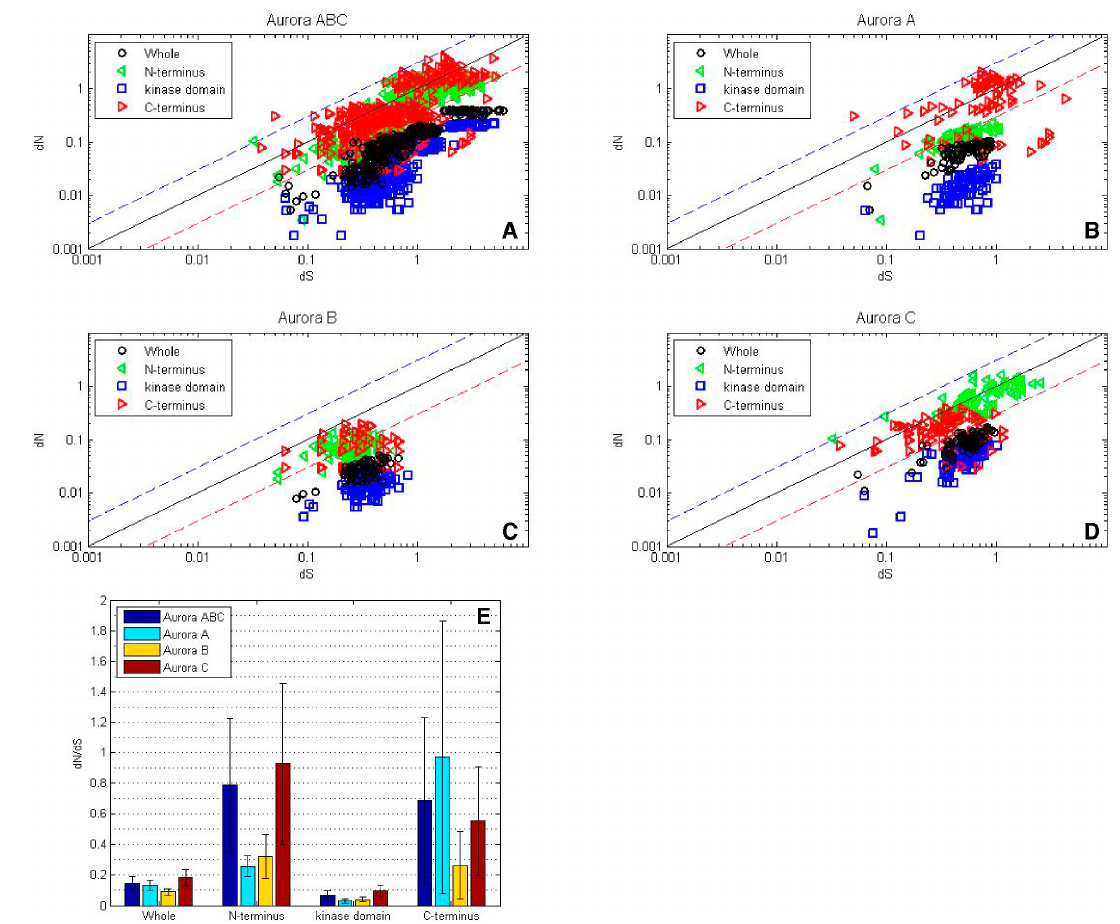
Figure 3. While the AK kinase domains experienced strong purifying selection, the N- and C-termini experienced either purifying or diversifying selection. A log-log plot depicting dN / dS values for the AK gene family. For each grouping, the values for the N-terminus are depicted by green triangles, the core are represented by blue squares, the C-terminus are depicted by red triangles, and the values for the entire gene are represented by black circles. The blue line corresponds to dN / dS = 1 and reflects neutrality. The dashed blue line corresponds to dN / dS = 3 and the dashed red line correspond to dN / dS = 0.3, this analysis was carried out with ( A ) the entire AK gene family, or with the individual isoform ( B ) AKA , ( C ) AKB and ( D ) AKC , ( E ) dN / dS values were calculated for the whole sequence as well as for the N- and C-termini and the kinase domain using all AK sequences (blue), as well as AKA (turquoise), AKB (gold) and AKC (maroon) sequence.